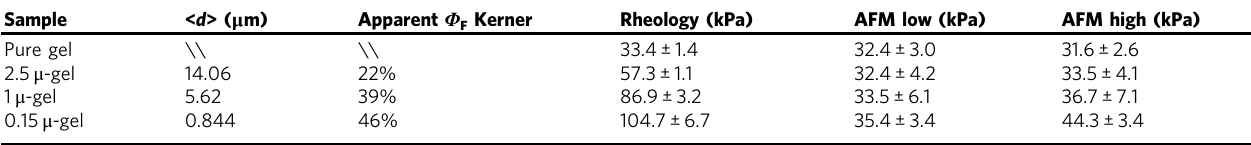
Table 1 Numerical values of moduli for composite gels along with theoretical parameters